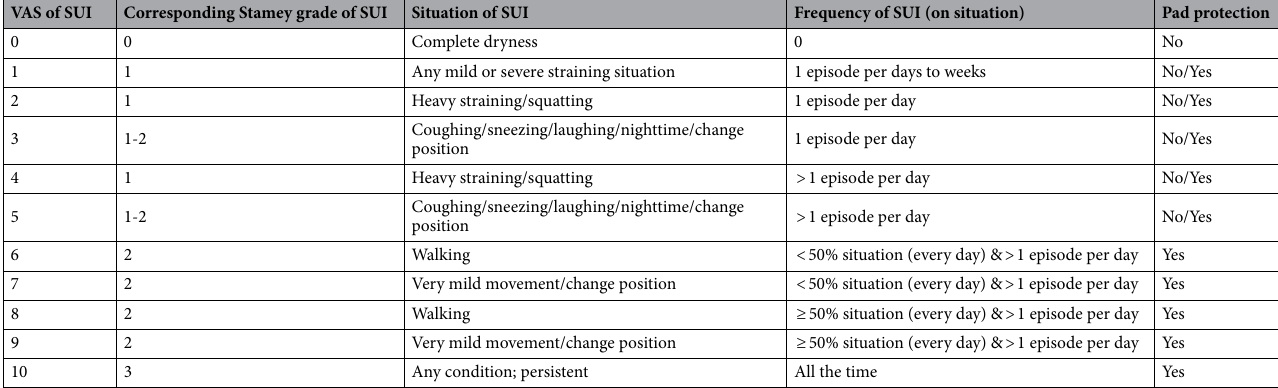
Table 3. Visual analogue scale (VAS) for assessment of stress urinary incontinence (SUI).